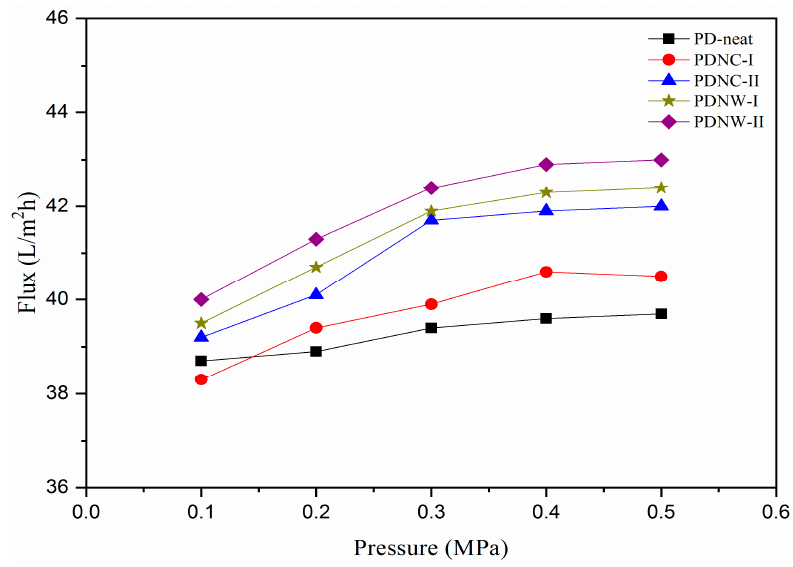
Figure 6. Water flux through membranes applied with different pressures.